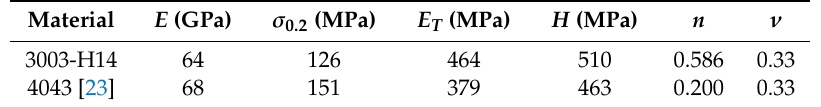
Figure 6. True stress–strain behavior for the 3003-H14 and 4043 aluminum alloys, data from [23]. Table 3. Tensile mechanical properties of the materials used for the finite element computation.